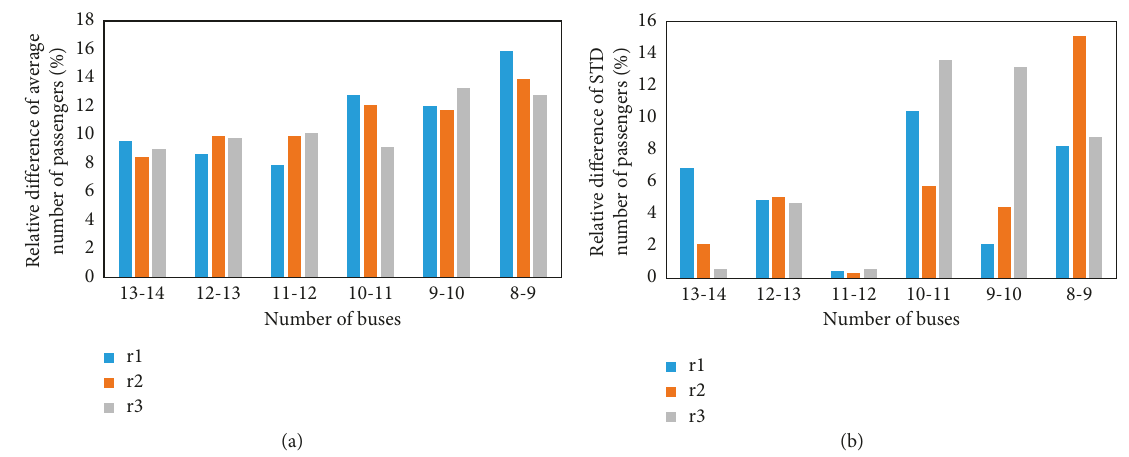
Figure 13: Index of passengers along with increasing buses on the route. (a) Relative difference of the average number of passengers at the busy section. (b) Relative difference of the STD number of passengers at the relatively empty